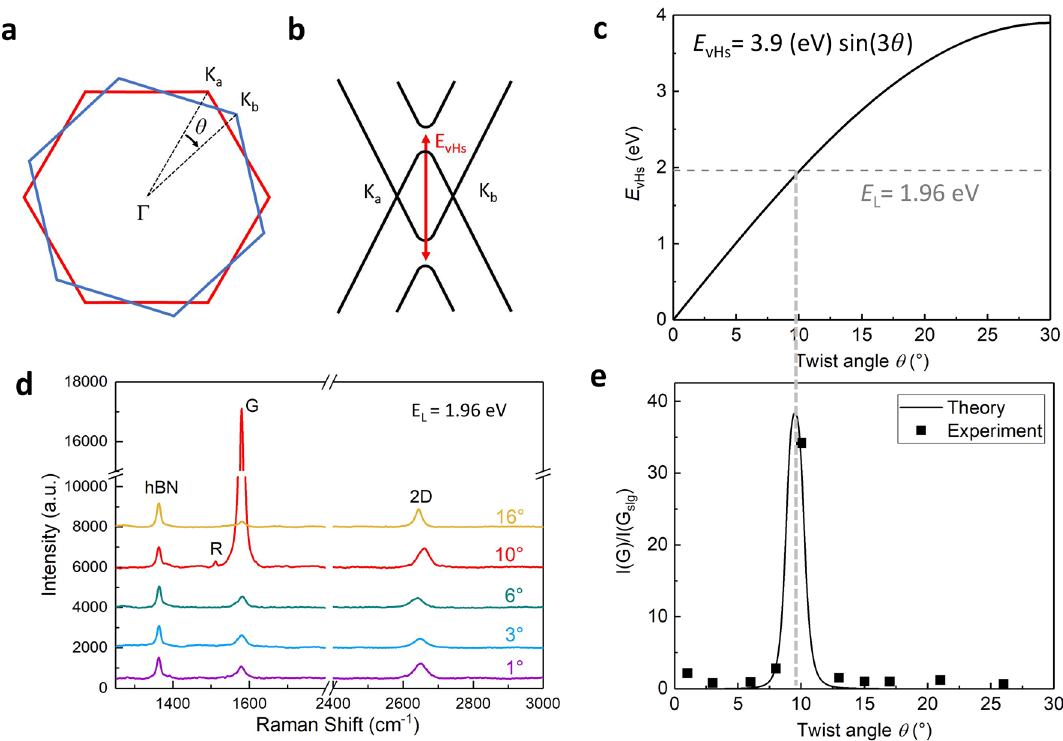
Figure 3. Large-range tuning of the twist angle to find the critical angle for resonant Raman. ( a ) The first Brillouin zone (BZ) of twisted bilayer graphene misoriented by θ . ( b ) Electronic bands in the vicinities of two Dirac cones. Van Hove singularities (vHs) are induced by band overlap. ( c ) Energy difference of the two vHs versus the twist angle θ. The gray dashed line indicates the excitation laser energy E L = 1.96 eV in our Raman measurement, corresponding to a twist angle of ~ 10°. ( d ) Raman spectra of a twistable bilayer graphene devices at a few representative twist angles. At θ = 10°, the graphene G-peak is largely enhanced. ( e ) The normalized graphene G-peak intensity as a function of the twist angle θ . Large enhancement at θ = 10° corresponds to the predicted resonant